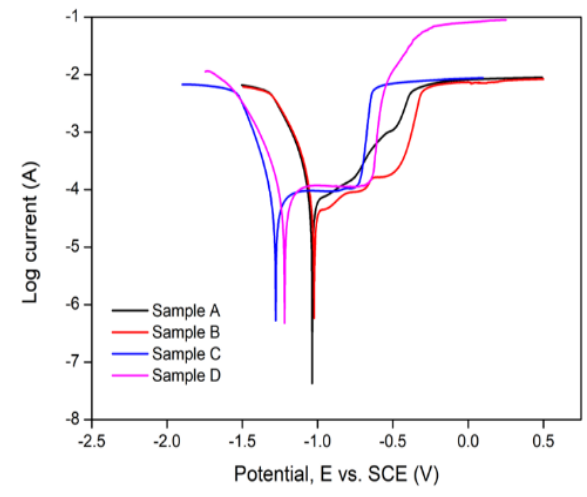
Figure 19. Tafel plots of samples A–D.